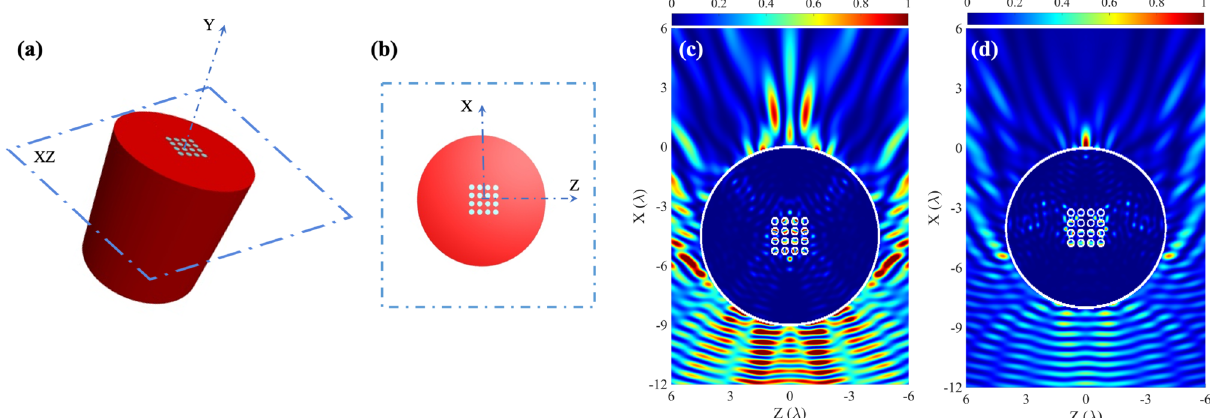
Figure 2. Schematic representation of the cylinder with a PhC embedded: ( a ) 3D view and ( b ) 2D view. Normalized intensity plane for numerical results for: ( c ) 4.5 (cid:31) radius ABS cylinder with an embedded 4 × 4 PhC and ( d ) 4 (cid:31) ABS cylinder with an embedded 4 × 4 PhC.